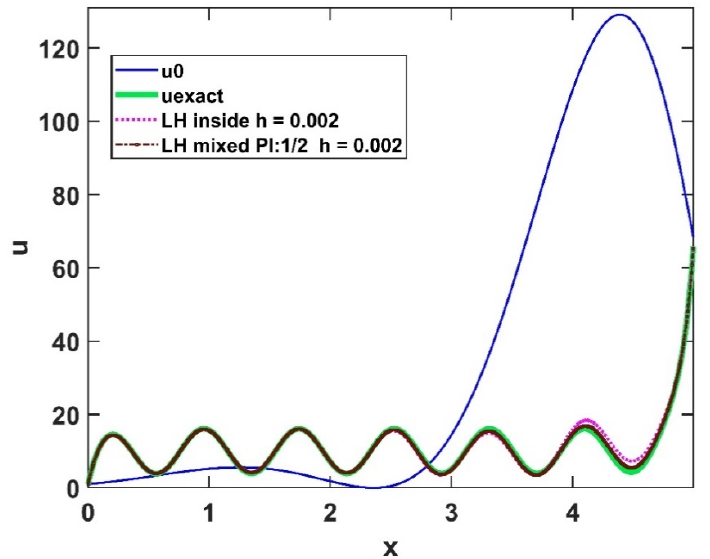
Figure 4. The L ∞ errors as a function of the time step size h for large K (Experiment 2). In Figure 5, we also present the initial and final temperatures for the LH method for 3 2 10 h − = ⋅ even in the case of these rather large errors.